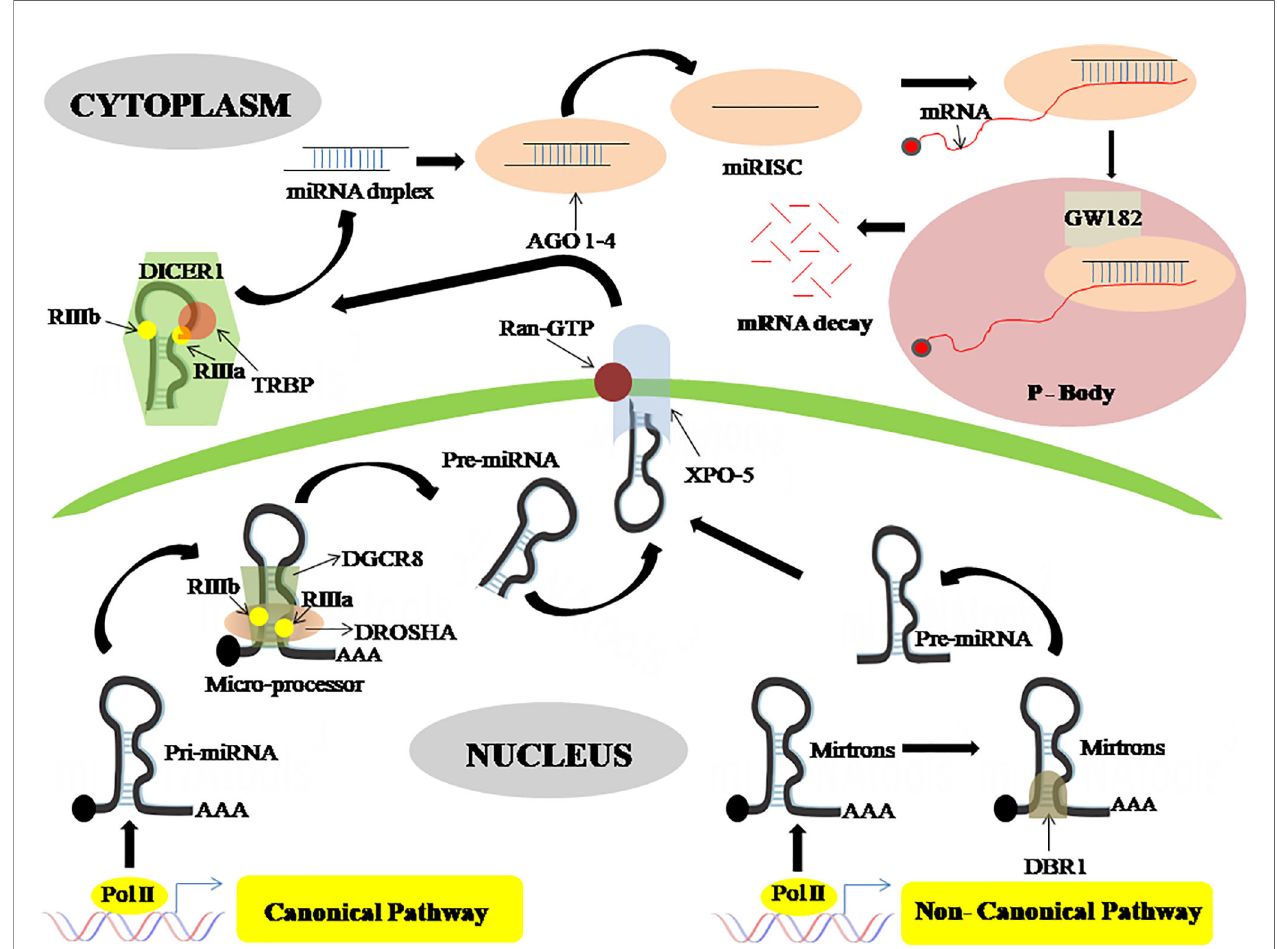
FIGURE 1 | MicroRNA biogenesis through a canonical and non-canonical pathway. In the canonical pathway the pri-miRNA is processed by DROSHA and DGCR8 to form pre-miRNA which then is exported to the cytoplasm via exportin-5, wherein the cytoplasm this pre-miRNA is processed by DICER-1 which gives rise to miRNA duplex. This miRNA duplex is then incorporated into RISC together with an argonaute protein to form mature miRNA. This mature miRNA then binds with an mRNA in the processing body where mRNA decay happens. On the contrary, in the non-canonical pathway, the pre-miRNA is generated from mitrons by DBR1. This pre-miRNA is transported by exportin-5 and enters the canonical pathway. DROSHA, Class 2 ribonucleaseIIIenzyme; DGCR8, DiGeorge syndrome critical region 8 gene; DBR1, Debranching enzyme; XPO-5, Exportin-5; DICER, ribonucleaseIIIenzyme; AGO, Argonaute protein; RISC, RNA-Induced Silencing complex; P- Body, Processing